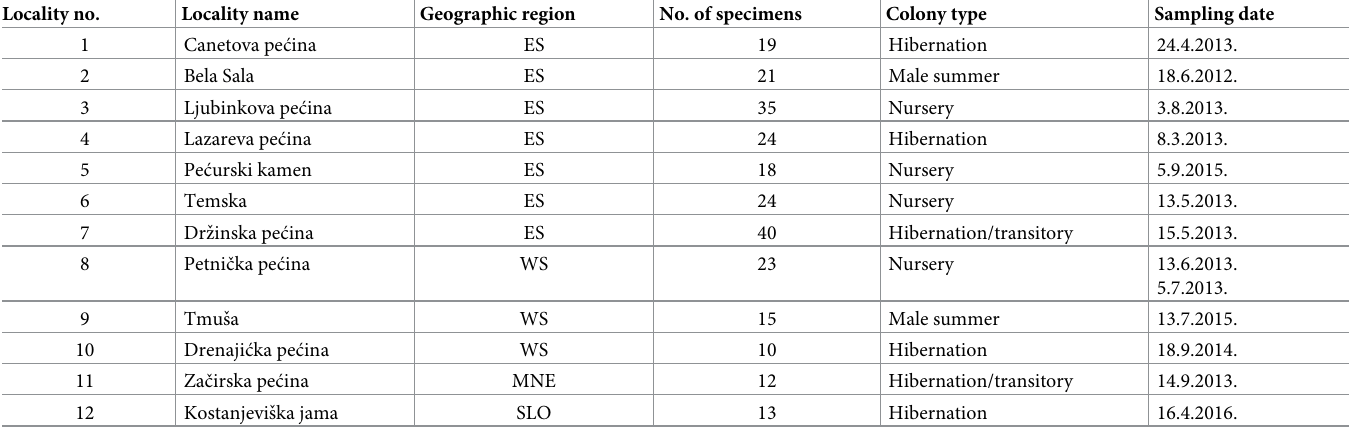
Table 1. List of sampled localities in the geographic regions with number of specimens sampled and colony type. Locality no.